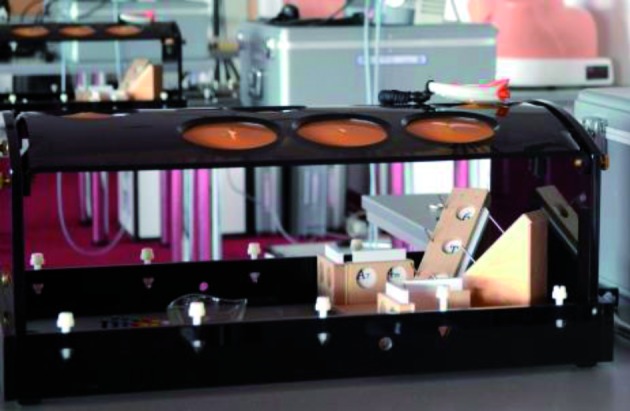
— Example: LASTT Model placed inside pelvic trainer. LASTT (Laparoscopic Skills Training and Testing Method) Training Model. The LASTT model is a validated training model that represents the spatial distribution and orientation of the different planes and angles of a female pelvis. It provides validated laparoscopic exercises to train and test the individual on their laparoscopic psychomotor skills (Campo et al. 2016b) (Campo et al. 2016b) (European Society for Gynaecological Endoscopy. and ProQuest Central. 2004) (Campo et al. 2012) (Palter et al. 2013) (Gala et al. 2013) (Burden, Oestergaard, and Larsen 2011) (Antoniou et al. 2012) (Hur et al. 2011) (Antoniou et al. 2012) (He et al. 2013) (Wang et al. 2016) (Nieboer et al. 2009) (Medeiros et al. 2009) (De Win et al. 2015) (Sinitsky, Fernando, and Berlingieri 2012) (Ascher-Walsh and Capes 2007) (Gala et al. 2013) (Ghomi et al. 2007) (Stefanidis, Acker, and Heniford 2008)